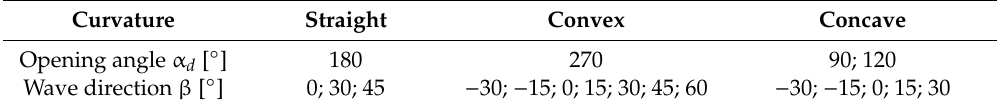
Table 1. Test configurations in the physical model.